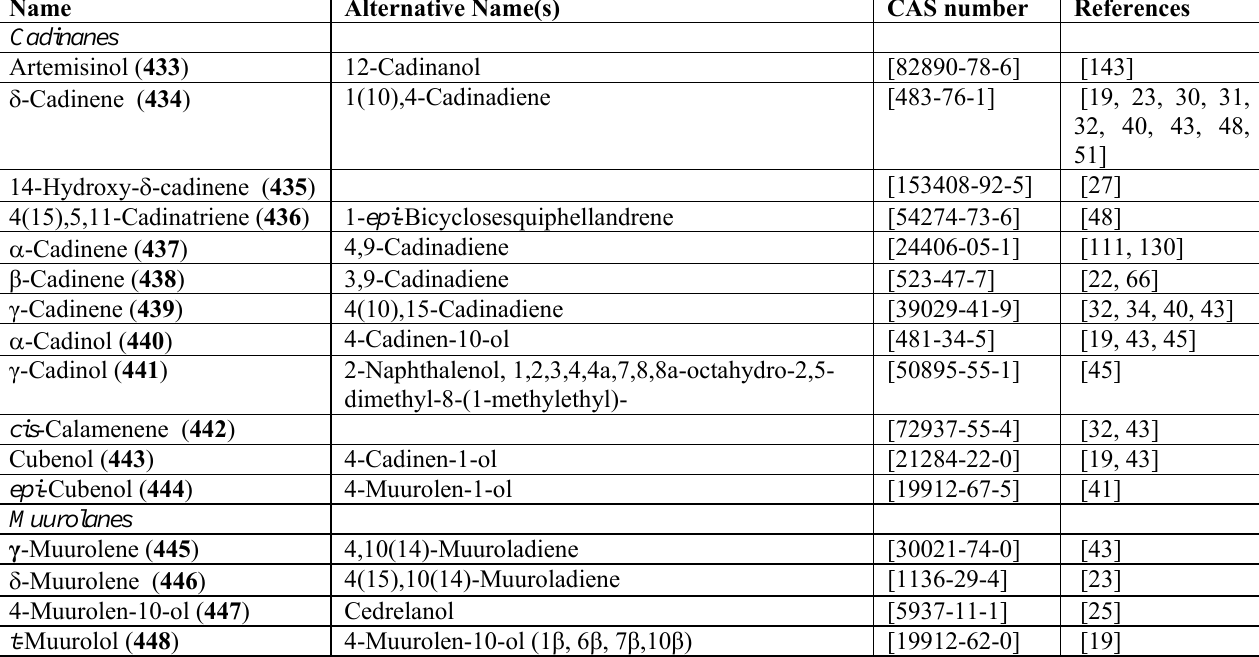
Table 35. Cadinane and Muurolane Sesquiterpenoids (Decahydro-1,6-dimethyl-4-(1- methylethyl)-naphthalene,